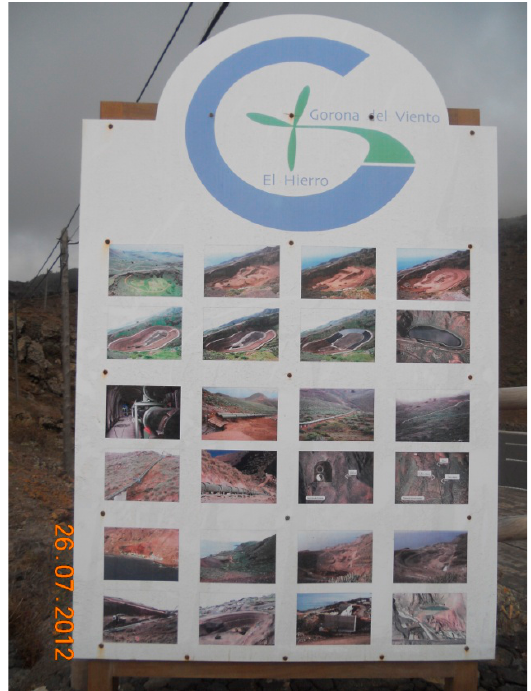
Figure 7. Information board presenting implementation of the Gorona del Viento Project. Photo: G.Jastrz ę bska.